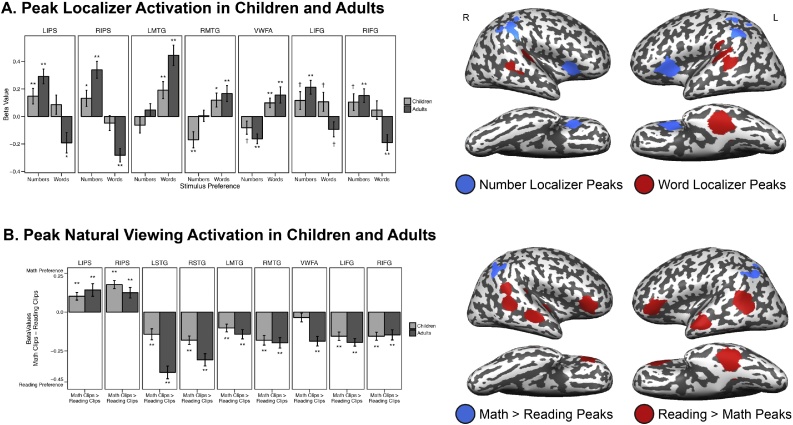
Region of Interest analyses for the localizer (A) and the natural viewing (B) GLMs. Sphere ROIs were created using the peaks from the GLM analyses in left (L) and right (R) intraparietal sulcus (IPS), middle and superior temporal gyri (MTG/STG), fusiform gyrus (VWFA, visual word form area), and inferior frontal gyrus (IFG). T-tests of beta values versus 0 for adults and for children show that the dissociation between mathematics in parietal cortex and reading in temporal cortex is evident in children alone. ** p < 0.01, * p < 0.05, † p < 0.10 Sphere ROIs were projected from volume space to surface space for consistency with other figures.